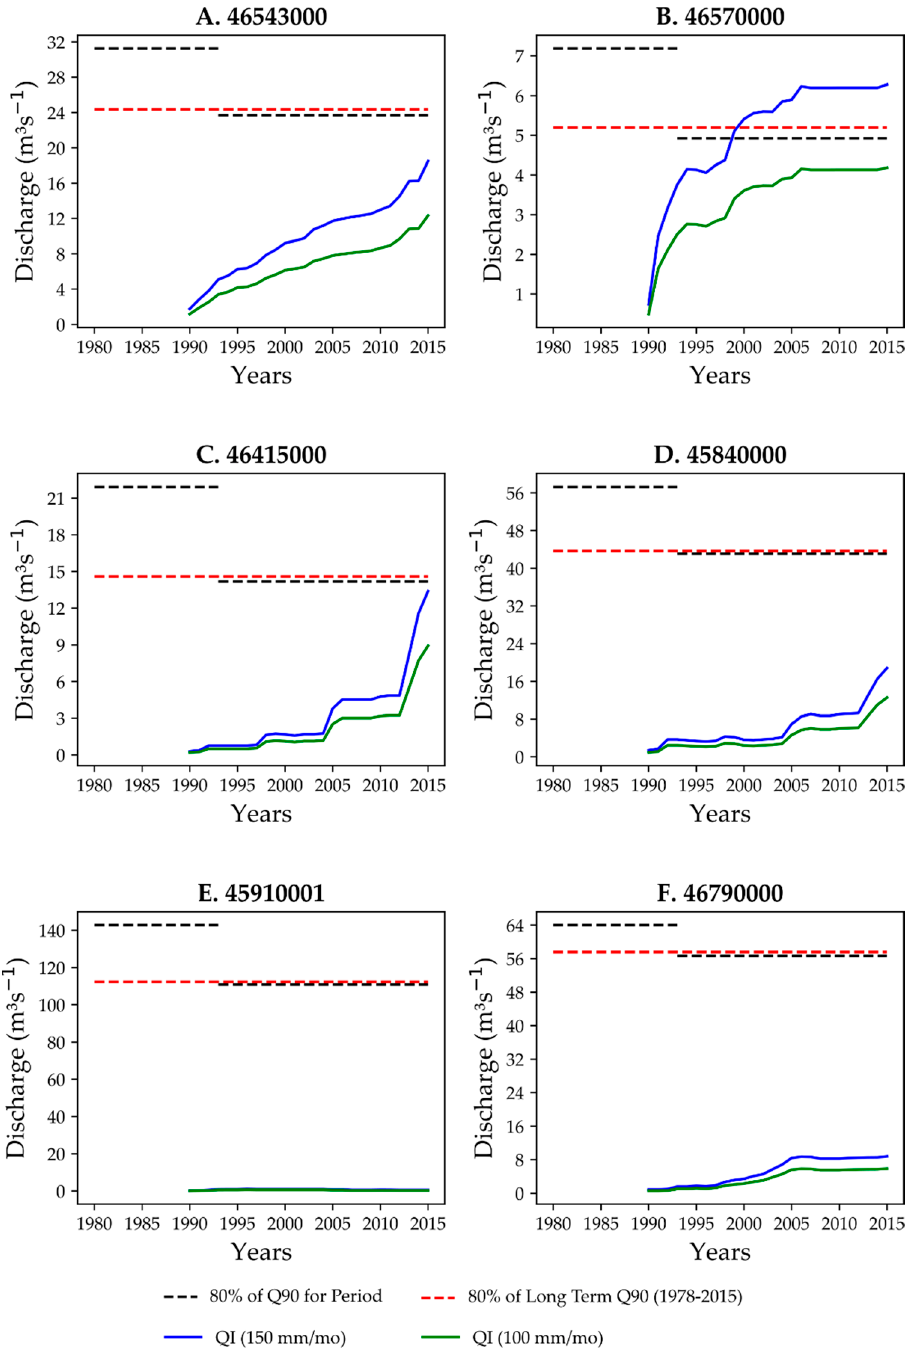
Figure 12. Evolution of discharge uptake for irrigation (QI) in the drainage area of each river flow station, assuming two water application rates (100 and 150 mm/month). 80% of long-term Q 90 (dashed red line) is the maximum that can be allocated at that point. The black dashed lines represent the change in the availability of water resources from P1 to P2.